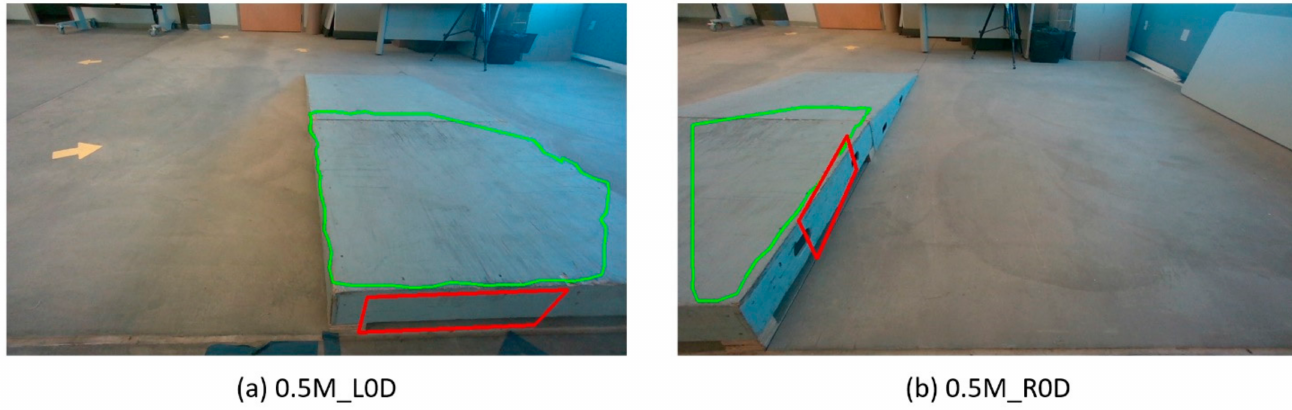
Figure 13. ( a ) Left side and ( b ) right side of the curb for curb detection comparison. The CRN system failed to detect the front of the curb in ( b ). Note that the RealSense camera is mounted on the right side of the MEBot, thus limiting its field of